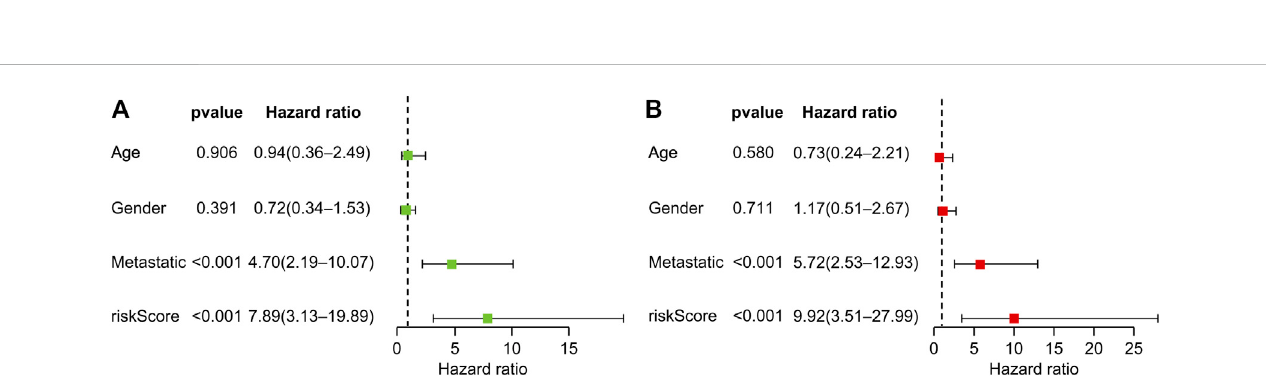
FIGURE 5 Prognostic value of clinical information and risk score. (A) Univariate Cox regression analysis of patients with osteosarcoma. (B) Multivariate Cox regression analysis of patients with osteosarcoma.